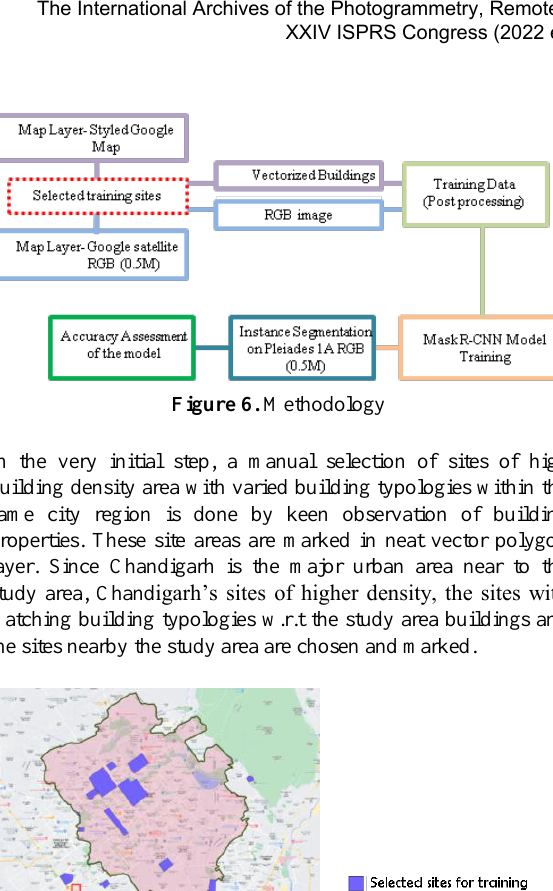
Figure 7. Location of sites selected for creating training data